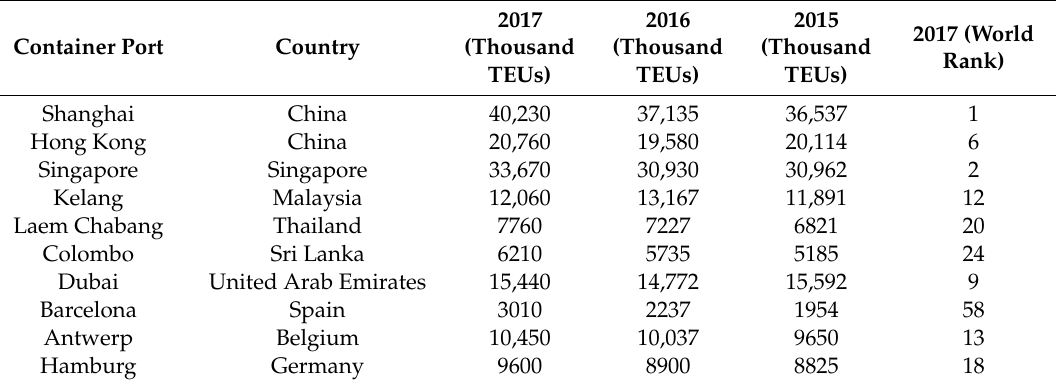
Table 2. Throughputs of the 10 container ports along the